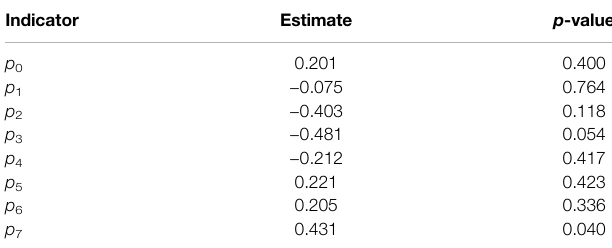
TABLE 3 | The regression parameter estimates and p -values for the indicator variables. Indicator